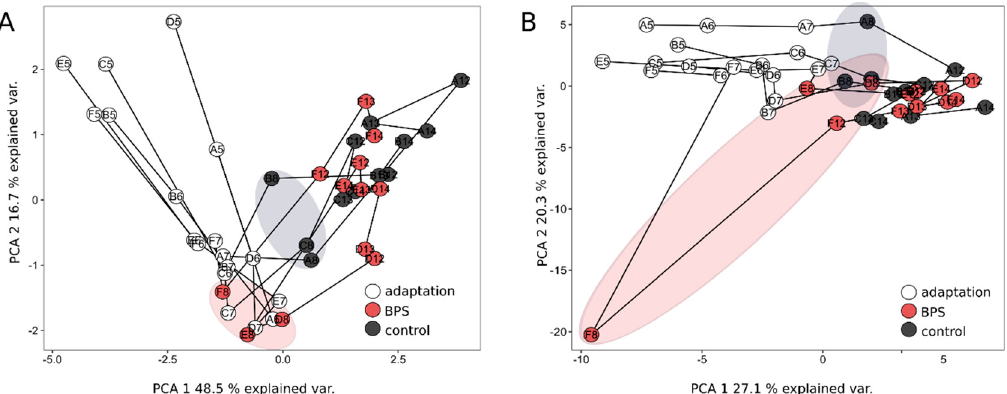
Figure 5. PCA analysis based on the relative protein abundance per species ( A ) and pathway ( B ). Lines connect different time points (day 5, 6, 7, 8, 12, 13, 14) per bioreactor (A, B, C, D, E, F). Ellipses mark the first day after the exposure to BPS.